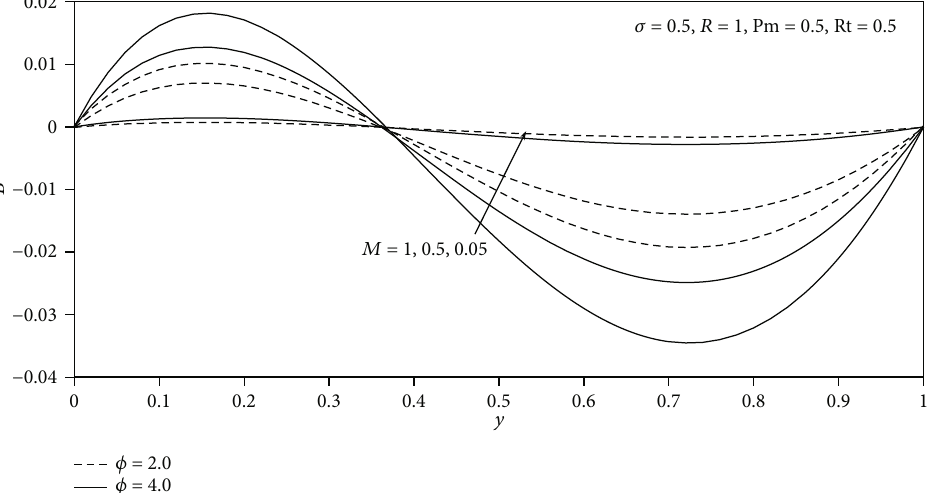
Figure 6: Induced magnetic fi eld for di ff erent values of M and ϕ .